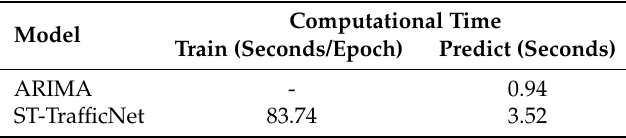
Table 4. The computational time of Autoregressive Integrated Moving Average (ARIMA) and ST-TrafficNet on dataset